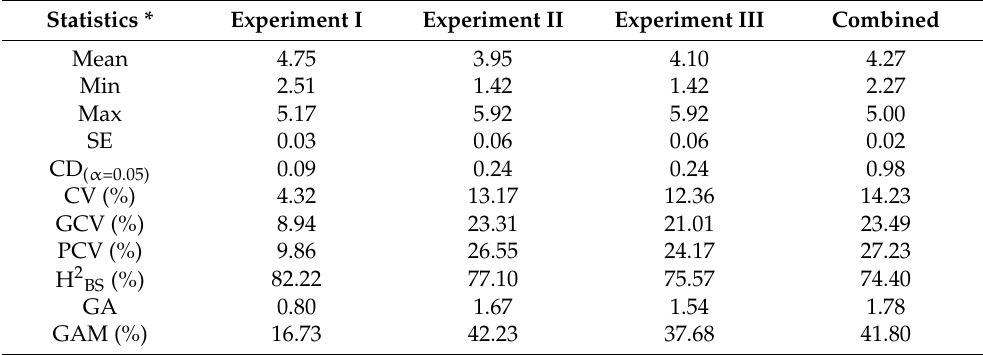
Table 2. Genetic variability statistics for aphid damage severity in the cowpea mini-core population evaluated in three screenhouse experiments.